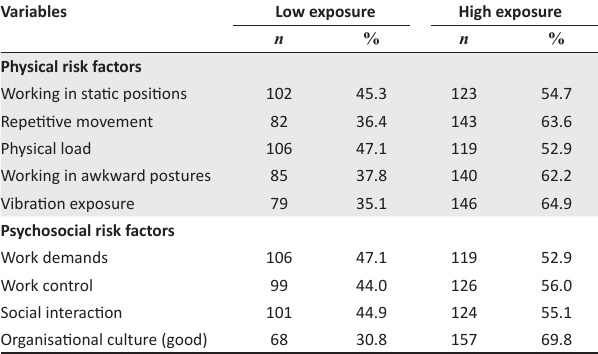
TABLE 3: Exposure to physical and psychosocial factors amongst female miners in a South African gold mine in 2017 ( n = 225). Variables